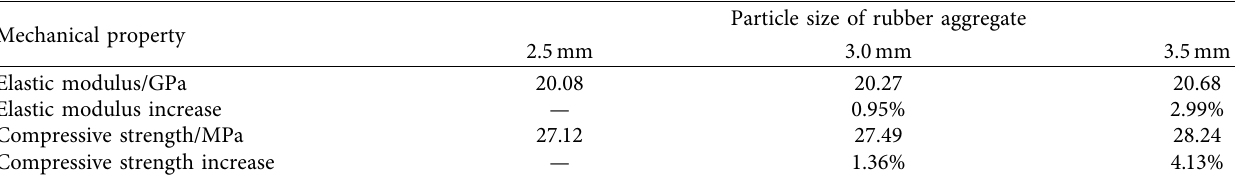
Figure 12: Compressive properties of rubberized concrete with different particle sizes. (a) Stress-strain relation, (b) compressive strength, (c) elastic modulus. Table 5: Elastic modulus and compressive strength of concrete with different particle sizes of